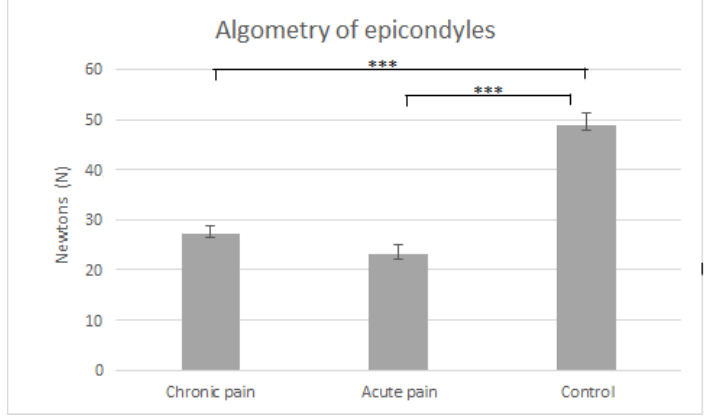
Figure 1. Means and typical errors of pressure pain thresholds (in Newtons) averaged for epicondyles in the three groups (chronic pain vs. acute pain vs. control). *** p < 0.001.